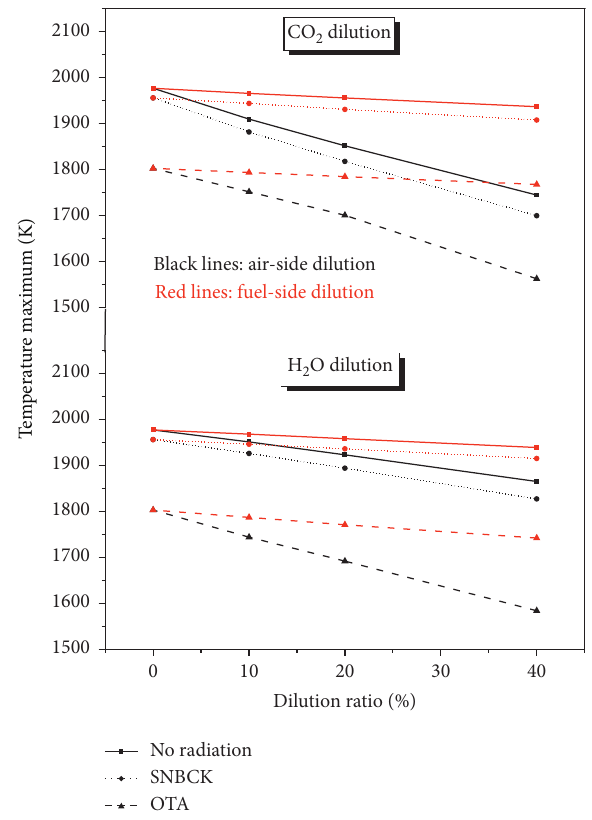
Figure 1: Variation of the peak flame temperature of CH counterflow diffusion flames with the dilution ratio for H 2 O and CO 2 addition to the air and fuel side: a s � 50s − 1 , L � 2cm,